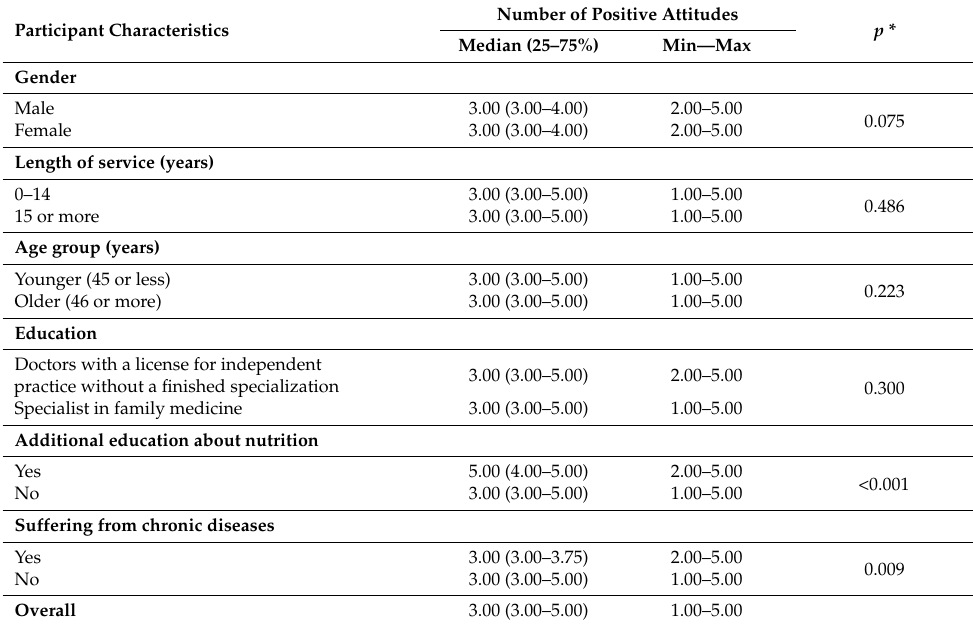
Table 2. Attitudes of the Croatian GPs toward the significance of nutrition in the treatment and prevention of chronic diseases according to the sociodemographic characteristics of study participants. Participant